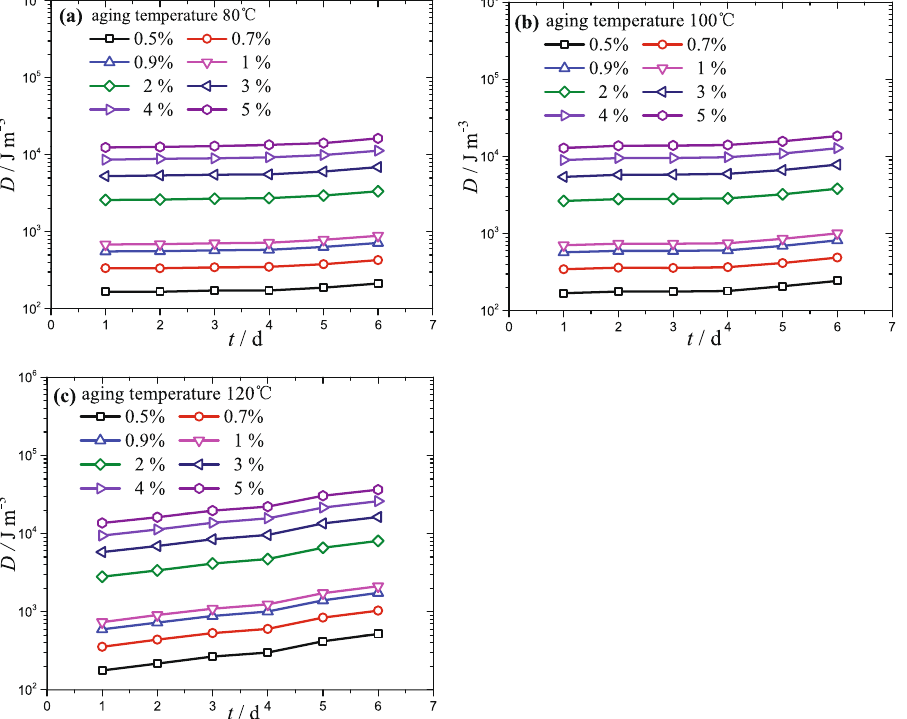
Fig. 6 Hysteresis loss as a function of aging time. The symbols represent the hysteresis loss under various dynamic strain amplitudes, i.e. 0.5%, 0.7%, 0.9%, 1%, 2%, 3%, 4% and 5%. The hysteresis loss increases with the aging time and dynamic strain amplitude for various aging temperatures: a 80 ℃ ， b 100 ℃ and c 120 ℃